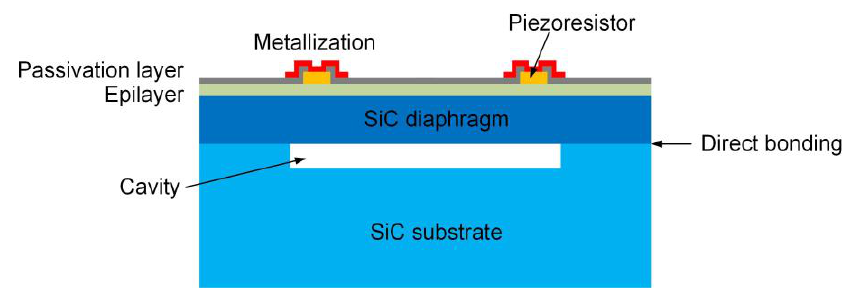
Figure 1. Structure schematic of the all-silicon carbide (SiC) piezoresistive pressure sensor.